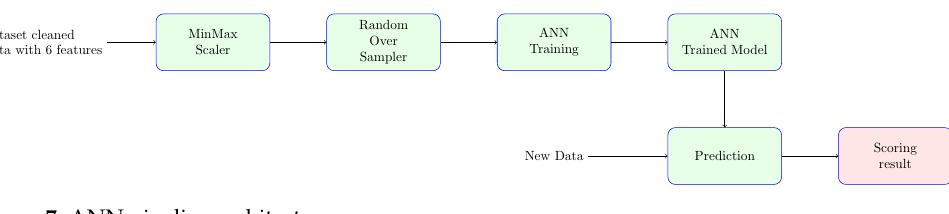
Figure 7. ANN pipeline architecture.